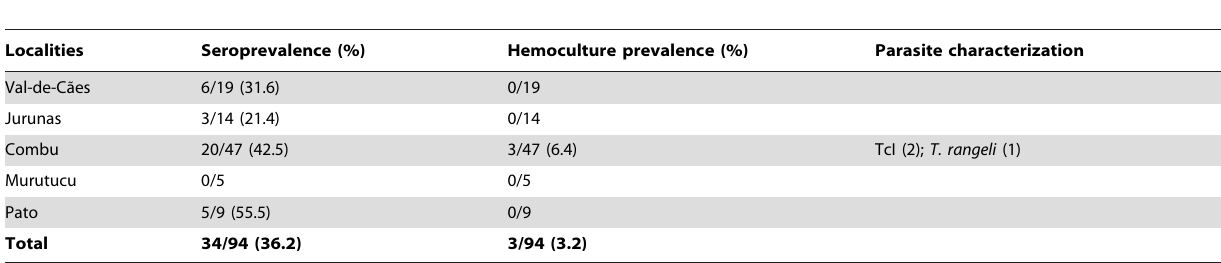
Table 2. Prevalence of Trypanosoma cruzi infection by IFAT/ELISA and hemocultures in dogs examined in Val-de-Ca˜es, Jurunas, and islands Combu, Murutucu and Pato, Bele´m municipality.